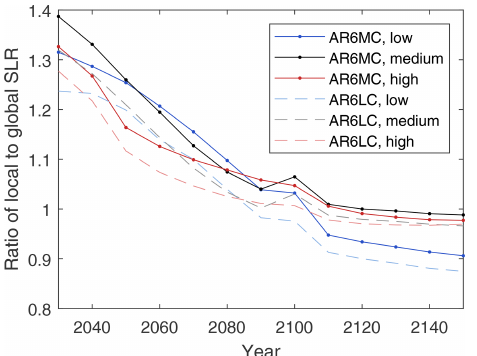
Figure 4. Ratio of local absolute sea level rise in Helsinki (with- out the effect of land uplift) to the global mean in IPCC AR6 median projections. Medium-confidence projections (AR6MC) are plotted with dark lines, low-confidence projections (AR6LC) with pale dashed lines, while colours indicate different emission scenar- ios: low (SSP1-2.6), medium (SSP2-4.5), and high (SSP5-8.5). Figure 5. The present-day land uplift (millimetres per year) over